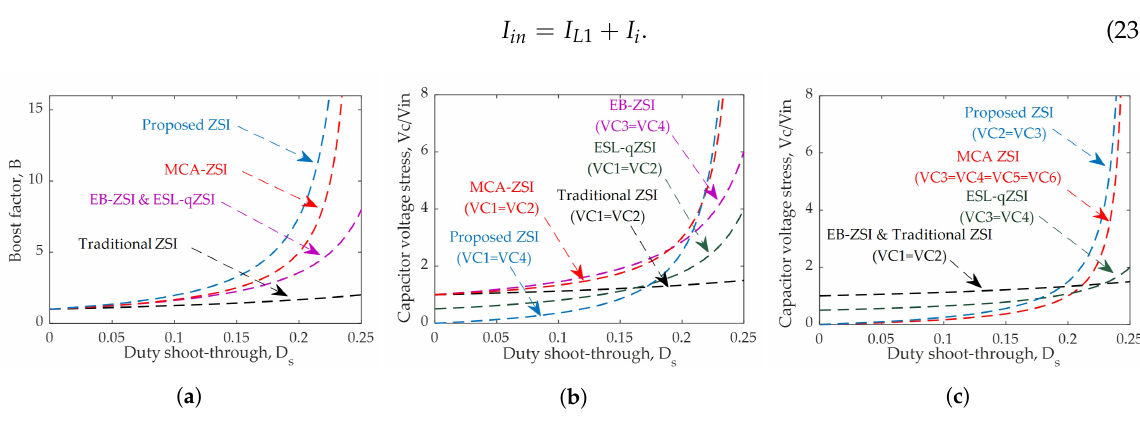
Figure 4. Characteristics curve: ( a ) boost factor, ( b ) capacitor voltage stress—high, ( c ) capacitor voltage